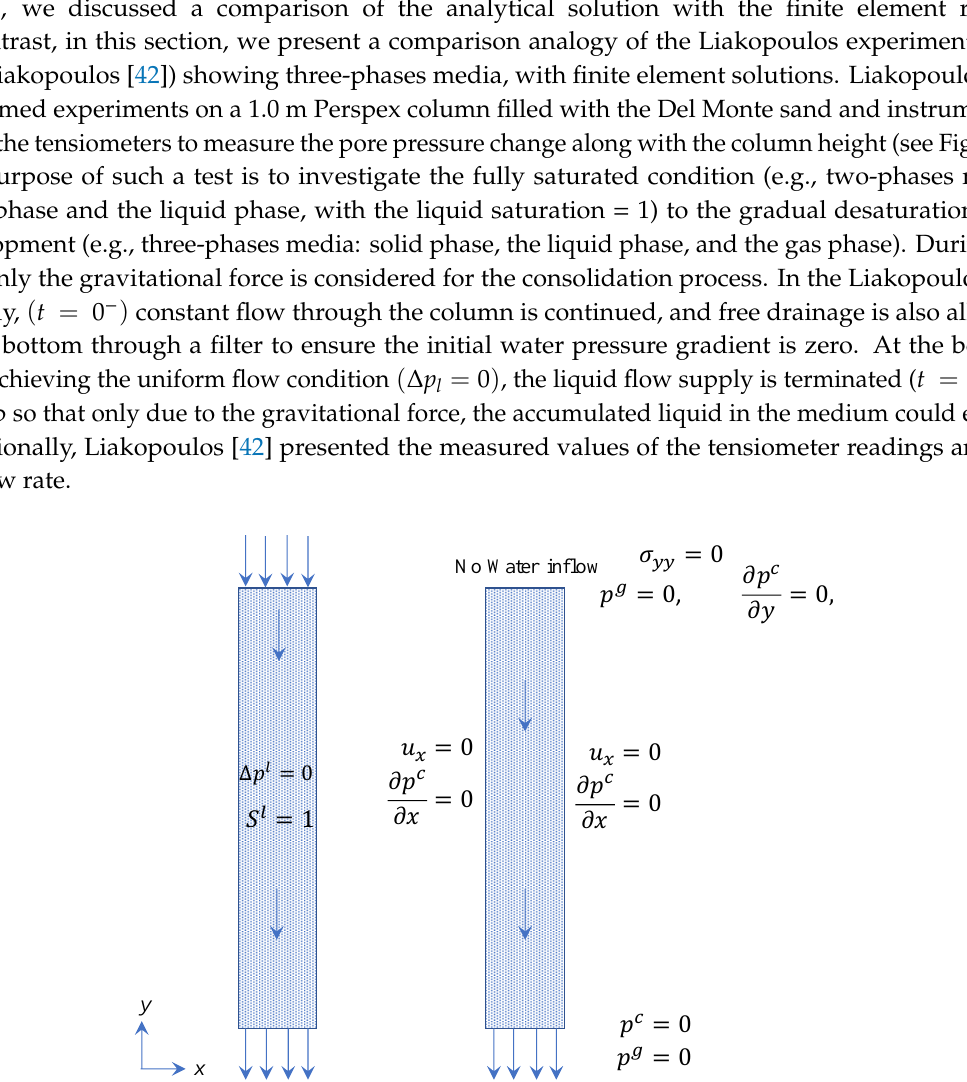
Figure 5. Liakopoulos test arrangement ( a ) 𝑡 = 0 − , and ( b ) 𝑡 = 0 + (Note: not in scale).